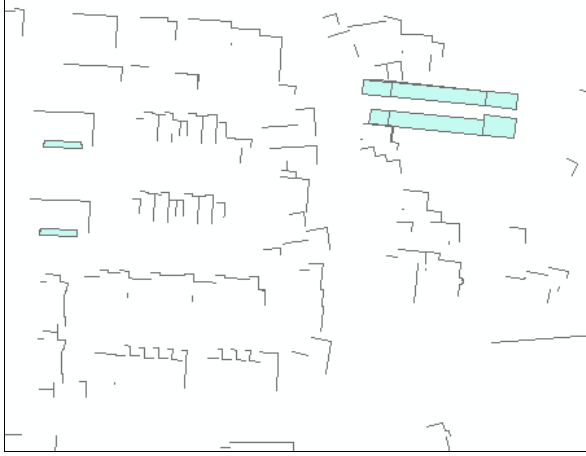
Figure 4. Difference-Layer with sliver